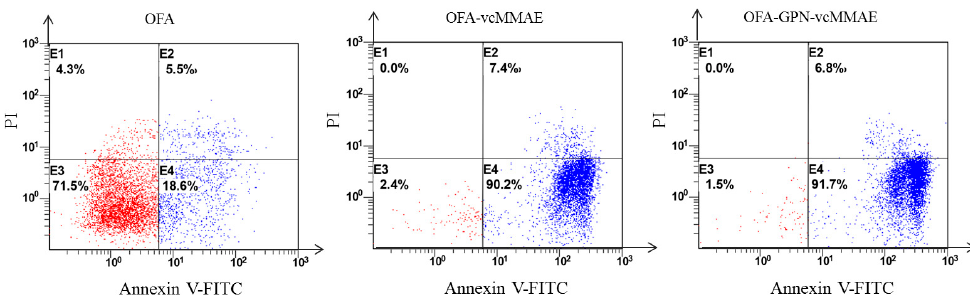
Figure 9. Effect of antibody and ADCs on induction of apoptosis in Ramos cells. Ramos cells were exposed to antibody, or ADCs at 5 μ g/mL for 72 h. Induction of apoptosis was detected using Annexin V-FITC and PI-Staining by flow cytometry. Late apoptotic and necrotic cells: AnnexinV-FITC+/PI+ (upper-right). Early apoptotic cells: Annexin V-FITC+/PI − (lower right). Next, we further evaluated the cytotoxicity in vitro and selectivity of the ADC, two CD20- positive B-lineage lymphoma cell lines (Daudi, Ramos) and one CD20-negative cell line (K562) were included. The results showed that unconjugated OFA possessed very low toxicity on two CD20- positive cells (IC 50 > 6.667 × 10 3 nM) (Figure 10). In contrast, OFA-GPN-vcMMAE (DAR = 3.3) effectively killed Ramos and Daudi cells with an IC 50 of 2.893 nM and 3.857 nM, respectively, while